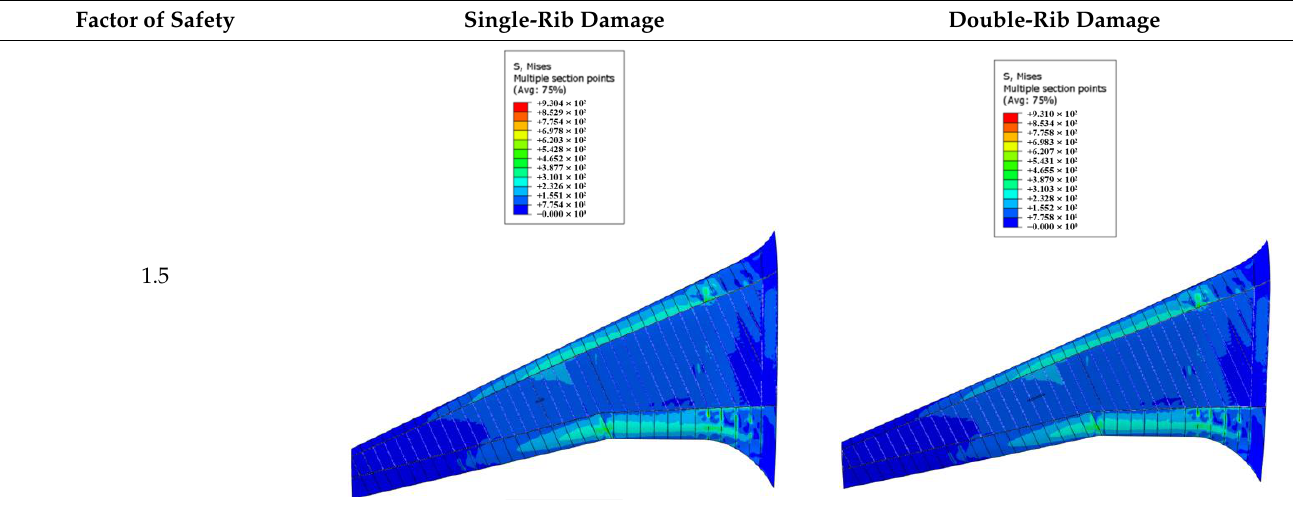
Table 15. Results of von Mises stress of single-rib and double-rib damage BWB wings at different values of F.o.S.